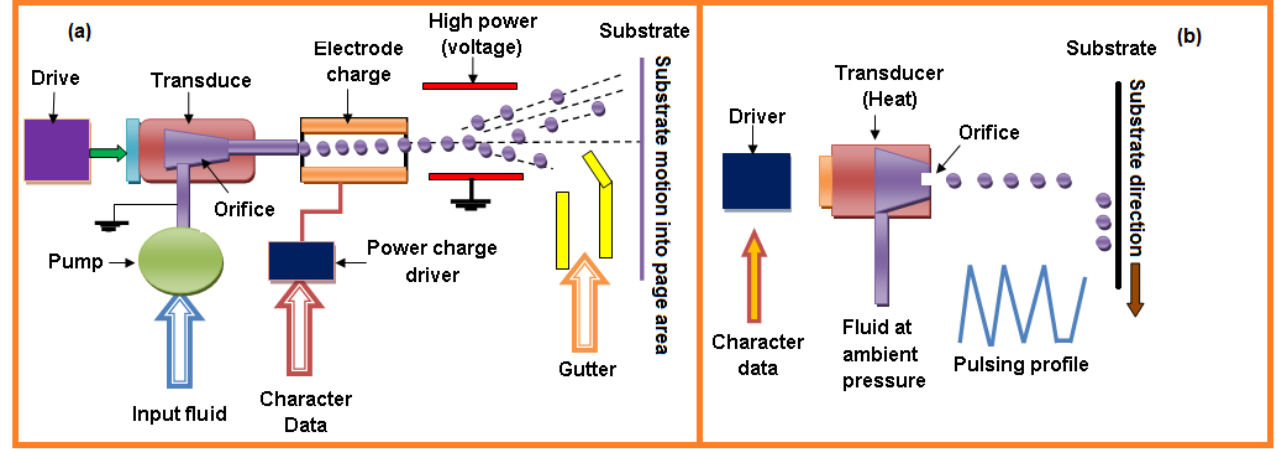
Figure 14. Schematic diagram of inkjet direct-write additive manufacturing process and continuous inkjet ( a ) and drop-on inkjet ( b ).